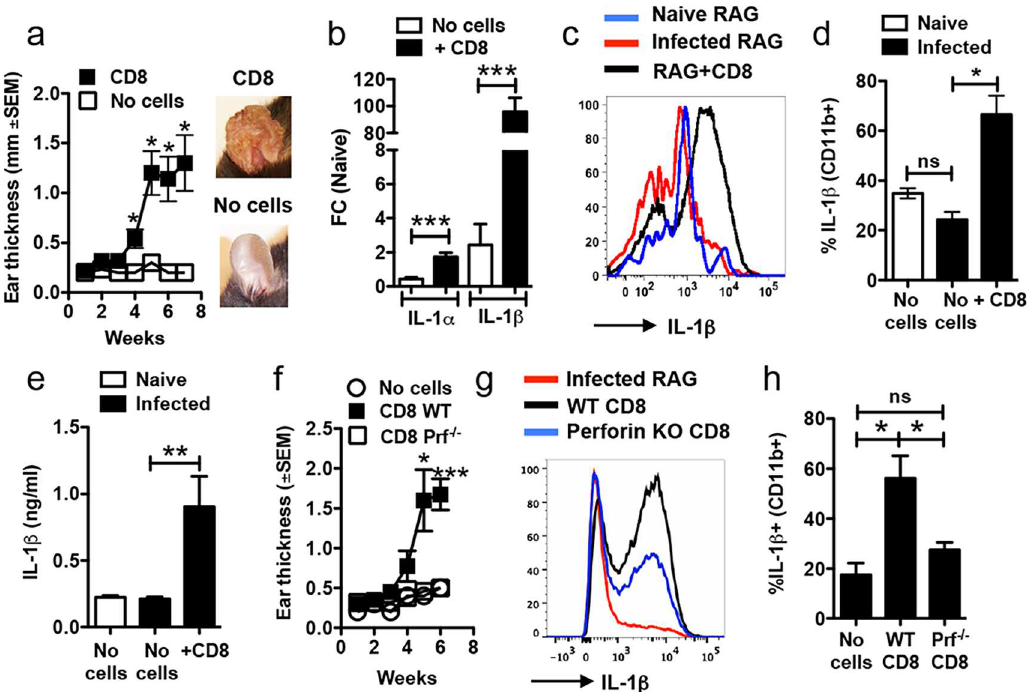
Fig 1. Increased IL-1 β in L . braziliensis lesions is dependent on CD8 T cell cytotoxicity. RAG-/- mice were infected with L . braziliensis in the ear, and reconstituted with CD8 T cells or did not receive cells and (a) the course of infectionwas monitoredand representative images of lesionsare shown. At 7 weeks post infectionmice were euthanized and (b) mRNA levels for IL1a and IL1b were assessed.mRNA data is representedas a fold change (FC) over expressionin na ï vemice. At 7 weeks post infection, lesionswere also digested and used for flow cytometric analysis. Depictedare (c) representative histogram and (d) bar graph of intracellularstaining for IL-1 β . (e) Ears were cultured for 48 hours and IL-1 β release was measuredin the supernatants by ELISA. RAG-/- mice were infected with L . braziliensis in the ear, and reconstituted with either WT or perforin-/- CD8 T cells or did not receivecells and (f) course of infectionwas monitored. At 7 weeks post infectionmice were euthanized, lesionswere digestedand used for flow cytometric analysis. Depictedare (g) representative histogram and (h) bar graph of intracellularstainingfor IL-1 β . Representative data from one of three or more independentexperiments (n = 3 to 5 mice per group) with similar results are presented. * p (cid:20) 0 . 05 or *** p (cid:20) 0 . 001; ns,